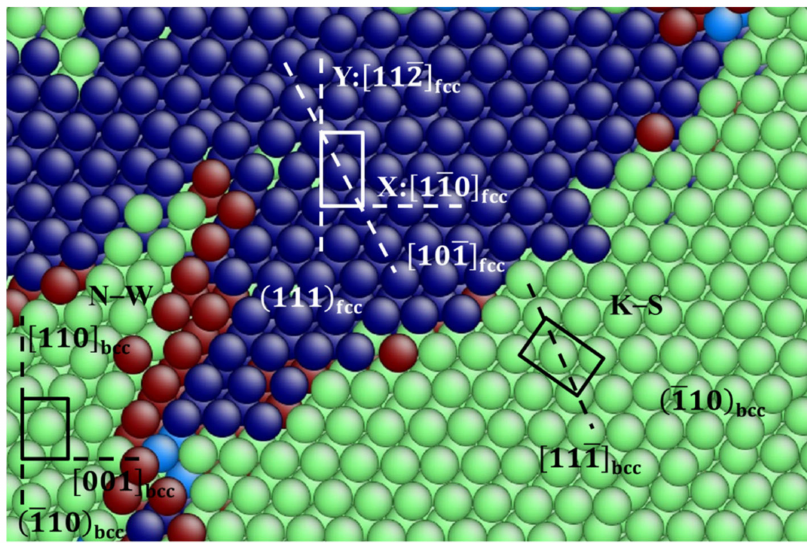
Figure 6. A zoomed snapshot of the ongoing martensitic phase transition in film 1 at 300 K, where the parent fcc phase and two types of bcc phases with di ff erent crystalline orientations coexist. The colors denote the local crystal structure as in Figure 5. The black rectangles indicate two di ff erent orientated bcc unit cells on the (110) bcc plane and the white rectangle shows a unit cell of fcc phase on the (111) fcc plane.